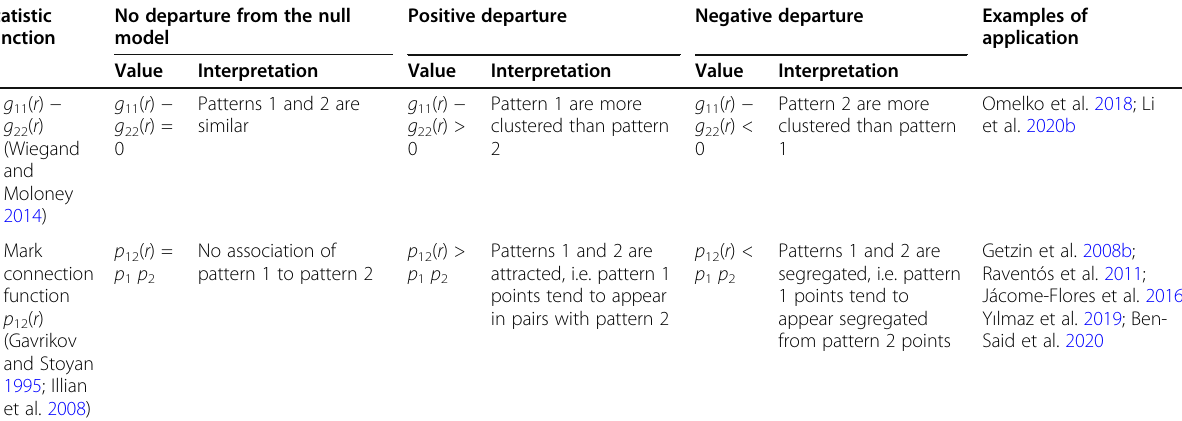
Table 1 Second-order summary statistics commonly used in spatial point-pattern analysis. In the univariate analysis, only one pattern is involved (e.g. one species, one size or age class, one life stage, etc.), while in the bivariate version two patterns (1 and 2) are investigated (e.g. two different species, two size classes, two life stages, etc.). For the mark correlation analysis, the most studied mark is by far tree diameter. In the case of random labelling analysis, the marks usually consist of tree status (e.g. dead vs living). For all analysis types, positive, negative, or absence of departure from the null model simulation envelopes occurs at a given scale r